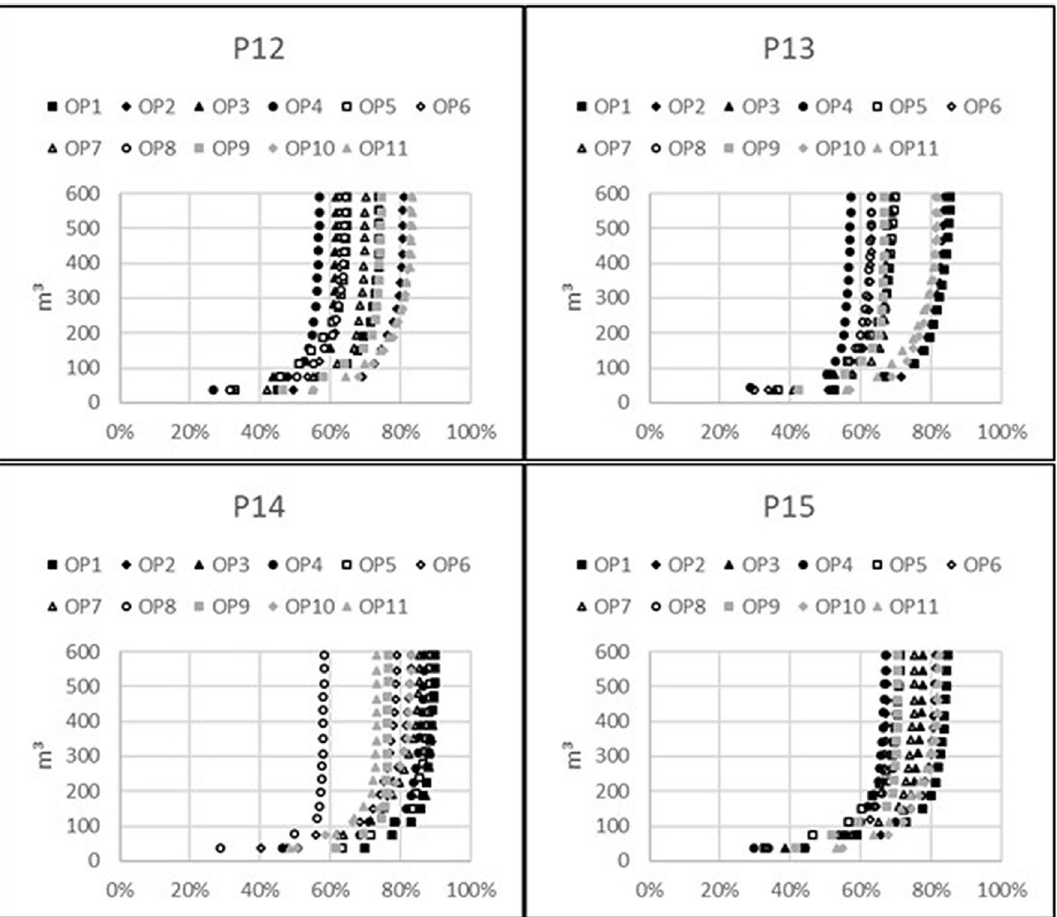
Figure 1. Volume of generated waste caused by topsoil removal with regard to relative dose reduction for 11 observation points inside a brick house on properties